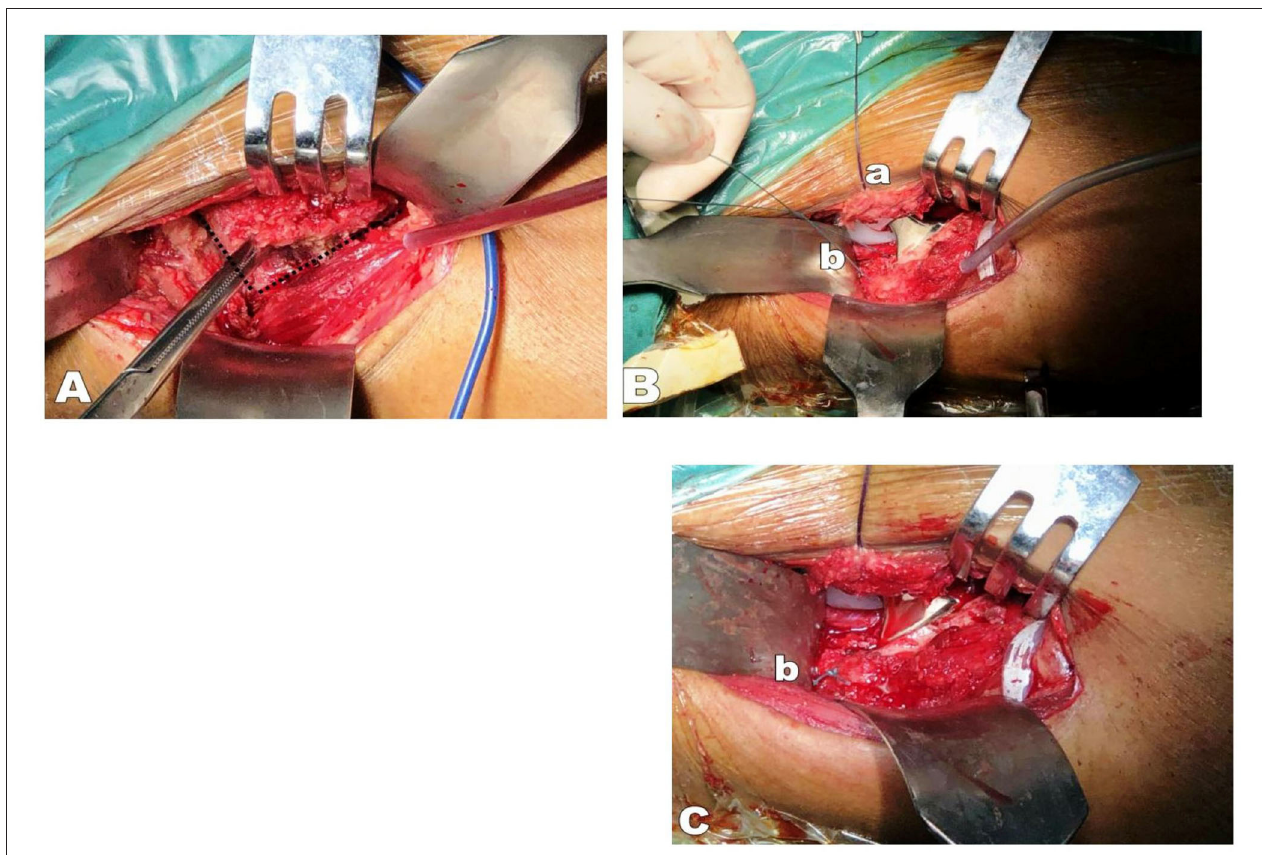
FIGURE 2 | (A) The black dotted line indicates the cut from the upper edge of the femoral neck to the intertrochanteric line in an “L” shape, with a margin of 2–3mm at the edge to facilitate the joint capsule reparation; (B) The loosened joint capsule was pulled (a) upward to expose the hip joint; Ethibond suture two was used to mark the conjoint tendon (b) in the proximal femur before it was cut off at the medial surface of the proximal femur of the greater trochanter (leave 2–3mm at the stump of the greater trochanter to facilitate reconstruction); (C) The conjoint tendon was repaired in-situ after the prosthesis was installed (b); (D) Completed repair of the joint capsule (a).